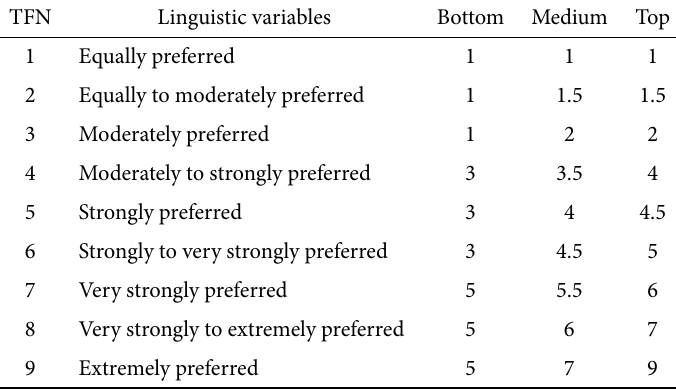
Table 9. Linguistic variables of alternatives